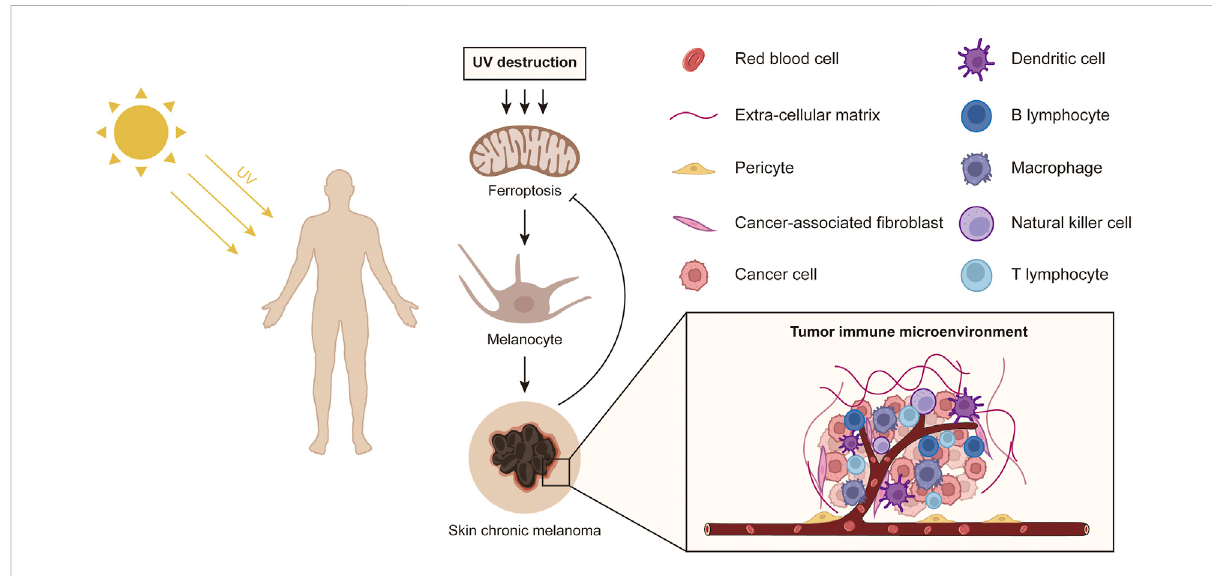
FIGURE 8 A schematic diagram shows the effect of sun exposure-induced ferroptosis mechanisms on potential biological processes of primary